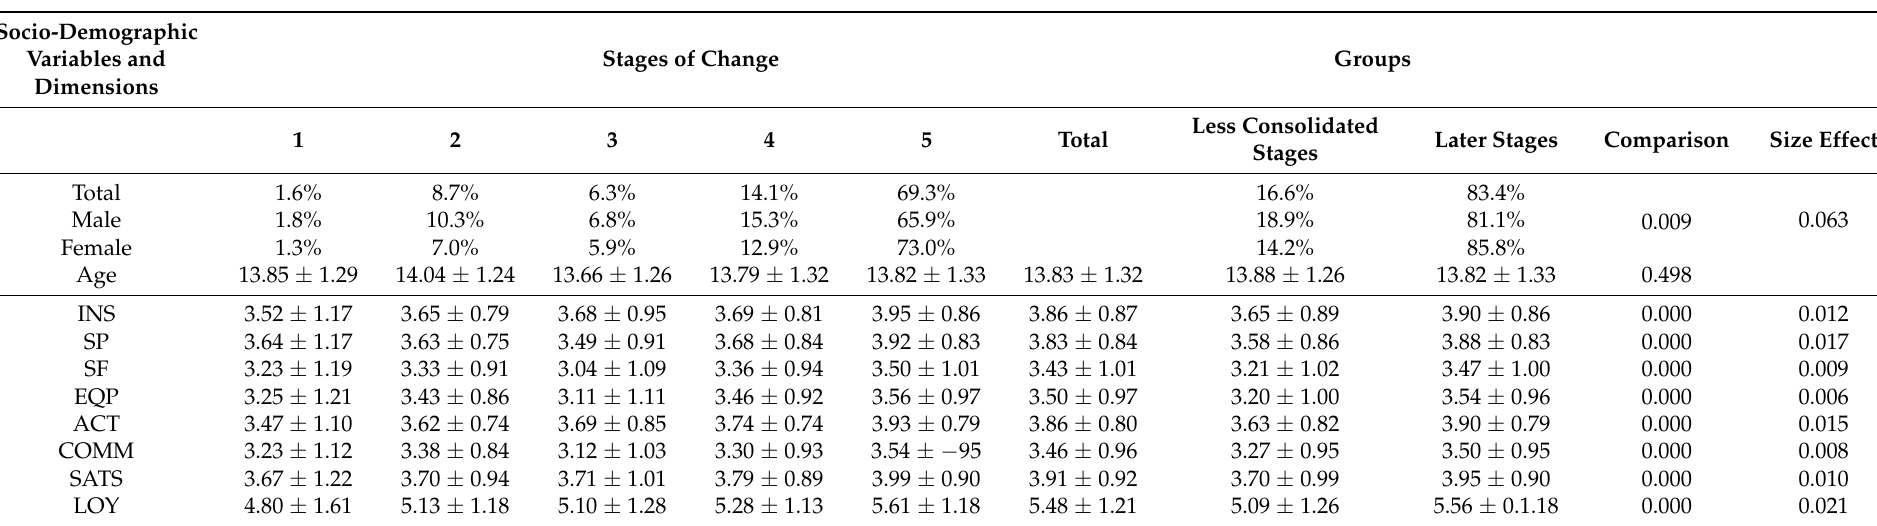
Table 2. Stages of change, gender, age, perceived quality, satisfaction, and loyalty. Percentages, means, and standard deviations. Contingency table and ANOVA.